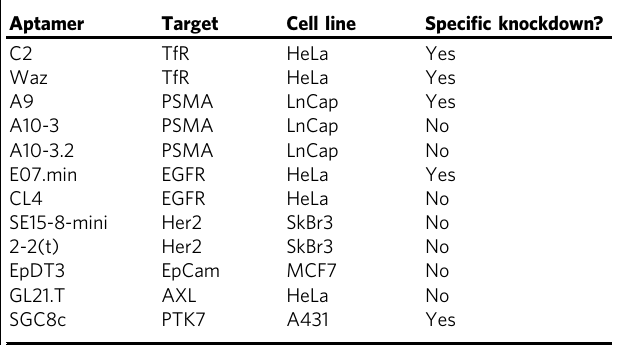
Table 4 Summary of target validation using siRNA